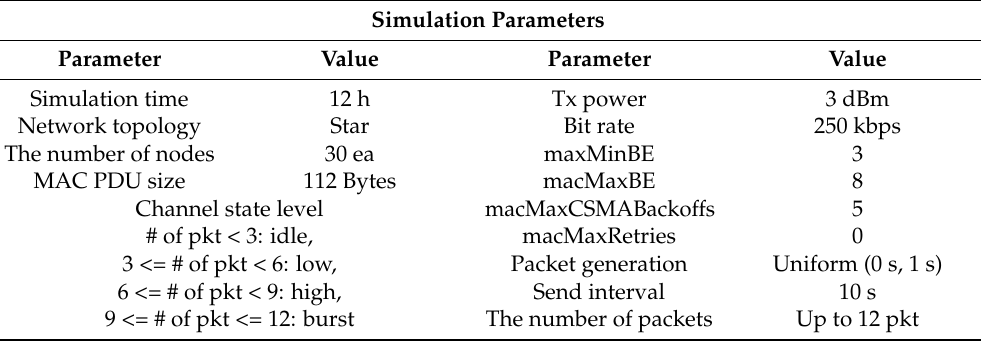
Table 1. Simulation Parameters for IEEE 802.15.4 with Q-Learning.